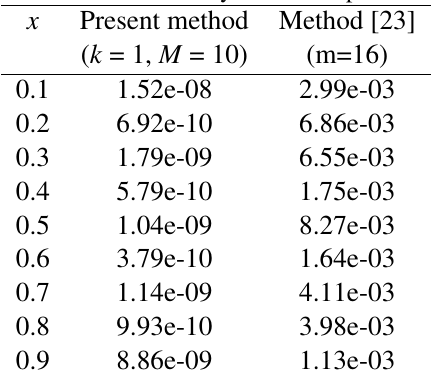
Table 5 Error analysis of example 3.